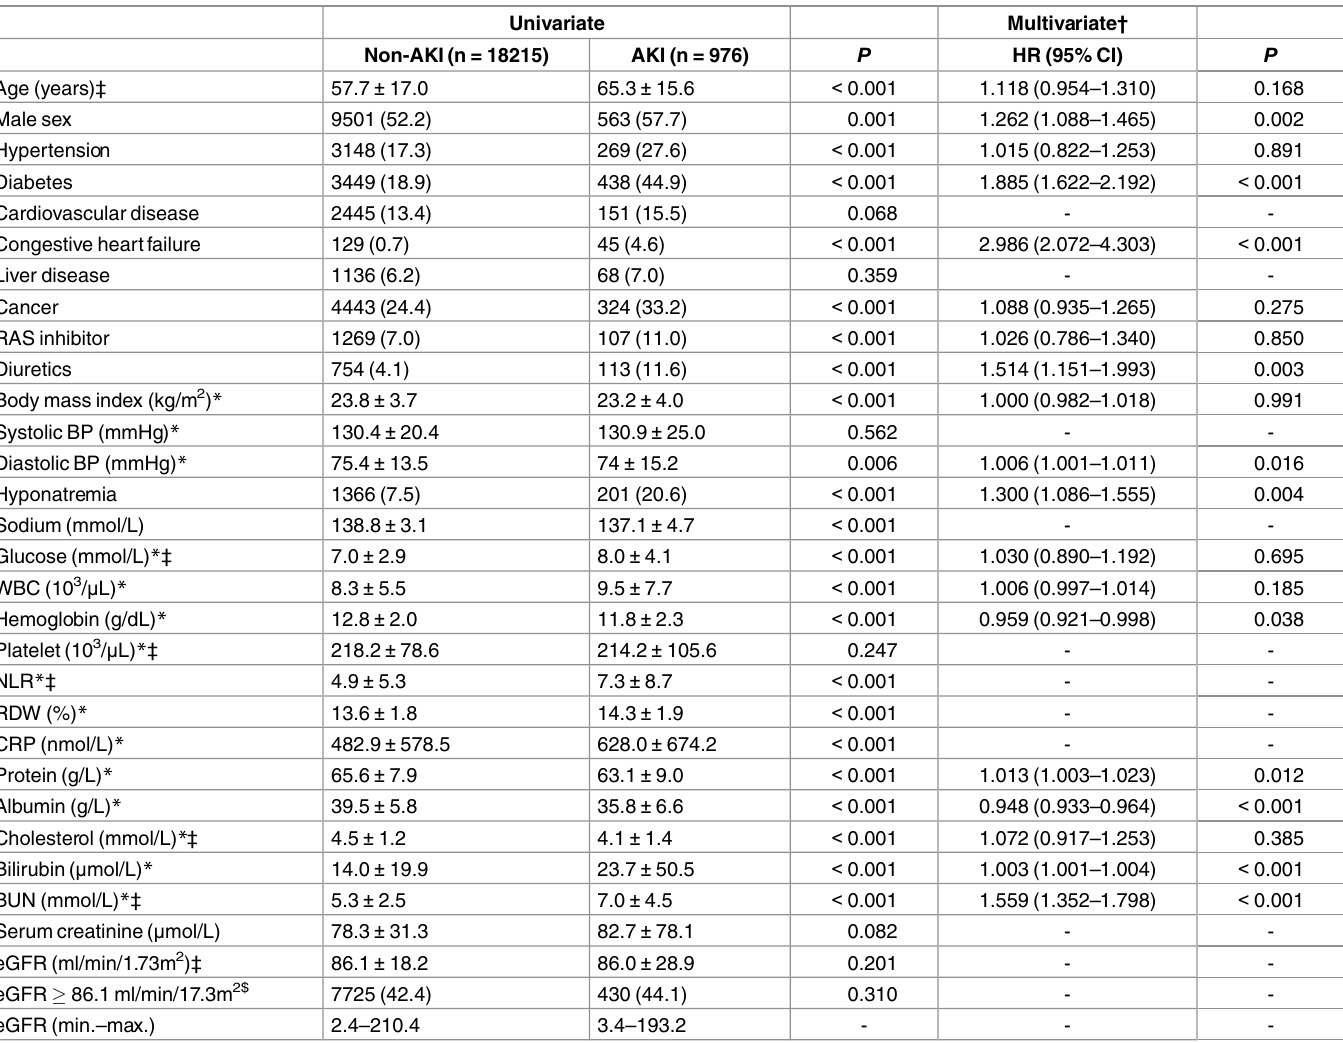
Table 2. Factors associated withacutekidney